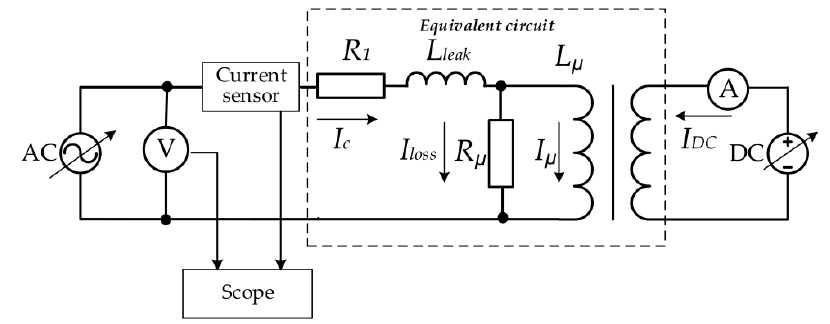
Figure 5. The equivalent circuit of the experimental setup for coil controllability measurement: R 1 —pure ohmic resistance of a working coil; L leak —inductance of a leakage magnetic field; R μ —resistance representing energy losses in the core; L μ —inductance of the coil; I c —coil current; I loss —current representing core losses; I μ —magnetization current.